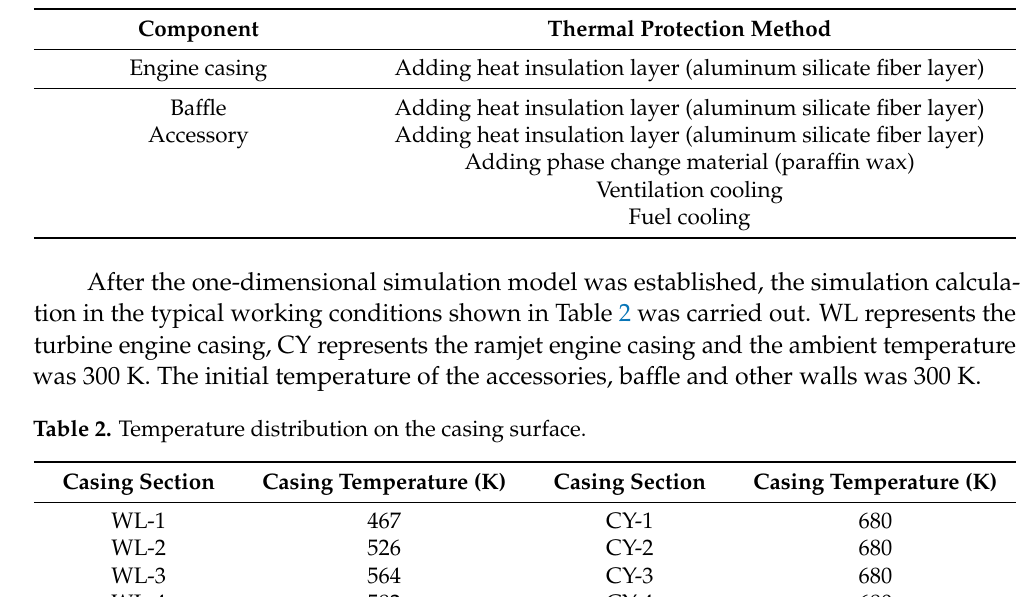
Table 1. Thermal protection method for each component.